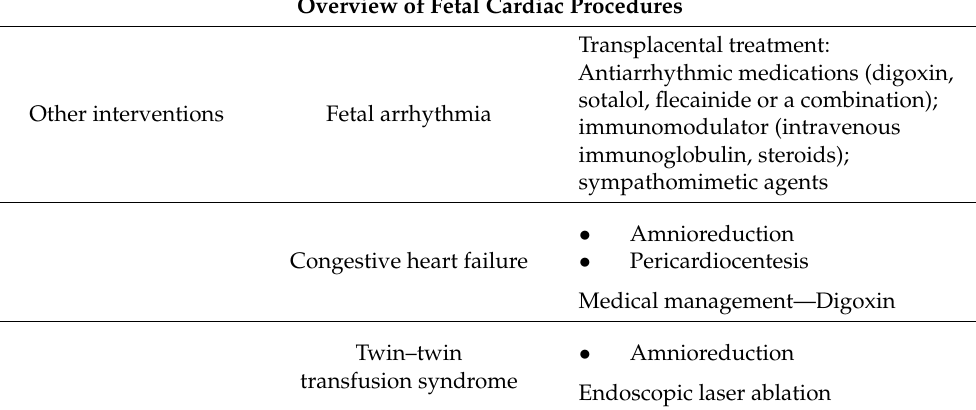
Overview of Fetal Cardiac Procedures